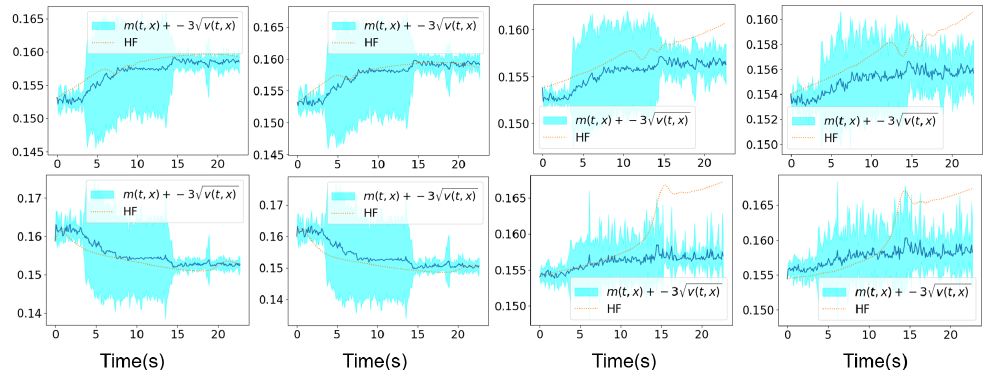
Figure 18. Mesh n°3: High-fidelity Yales2 horizontal velocity projected on the Cartesian mesh in brown and the horizontal component of the mean prediction of the Bayesian ROM in dark blue, at eight different spatial locations. The training data correspond to 15 s simulation time starting from 0 s. An extrapolation is performed from 15 s until 22.64 s. The clear blue zones are the ones contained in three standard deviations around the mean prediction of the ROM denoted m ( t , x ) . The mean prediction is obtained using an aggregation of five samples of the Navier–Stokes solution by the Bayesian nonlinear